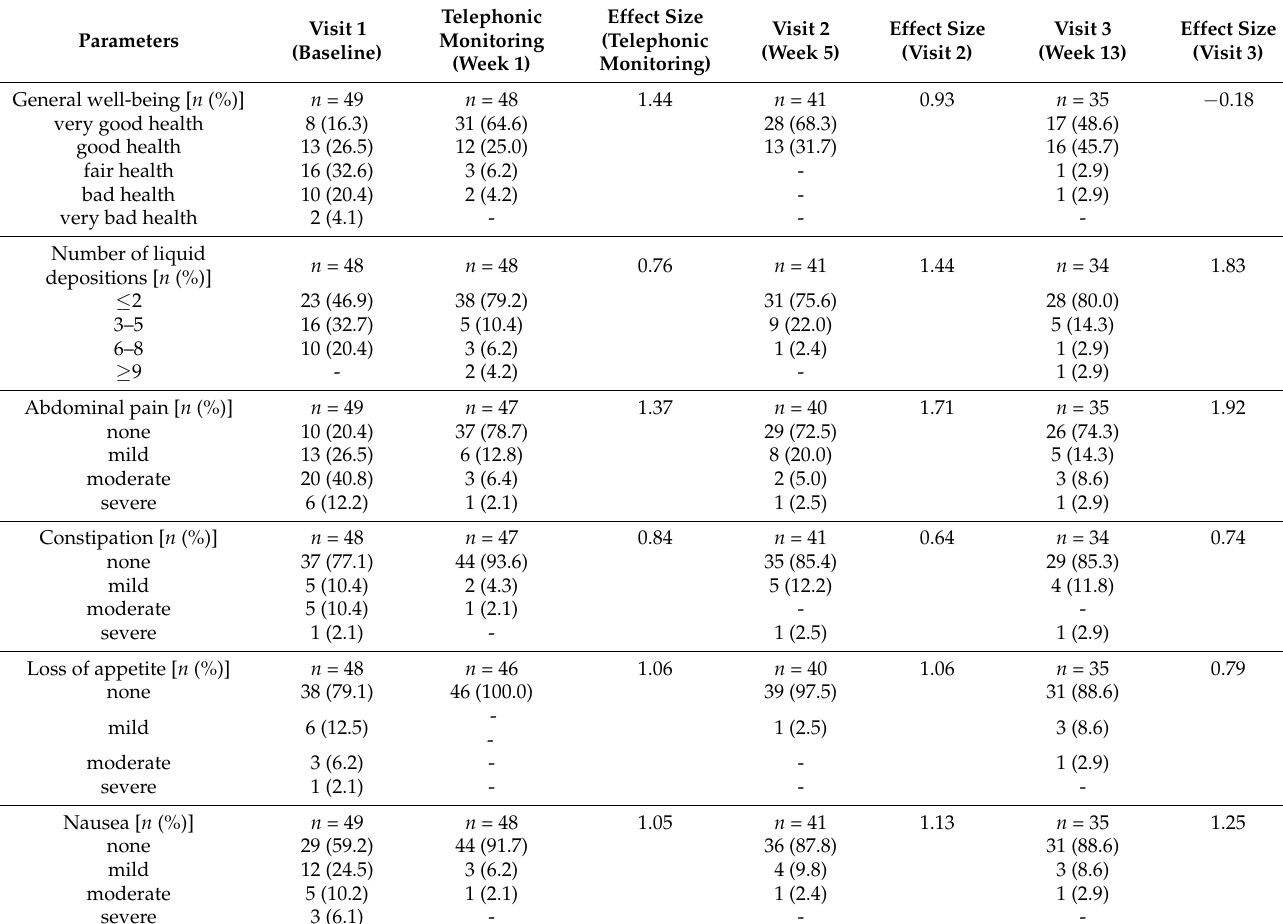
Table 2. Tolerability of oral iron supplementation with Sucrosomial ®